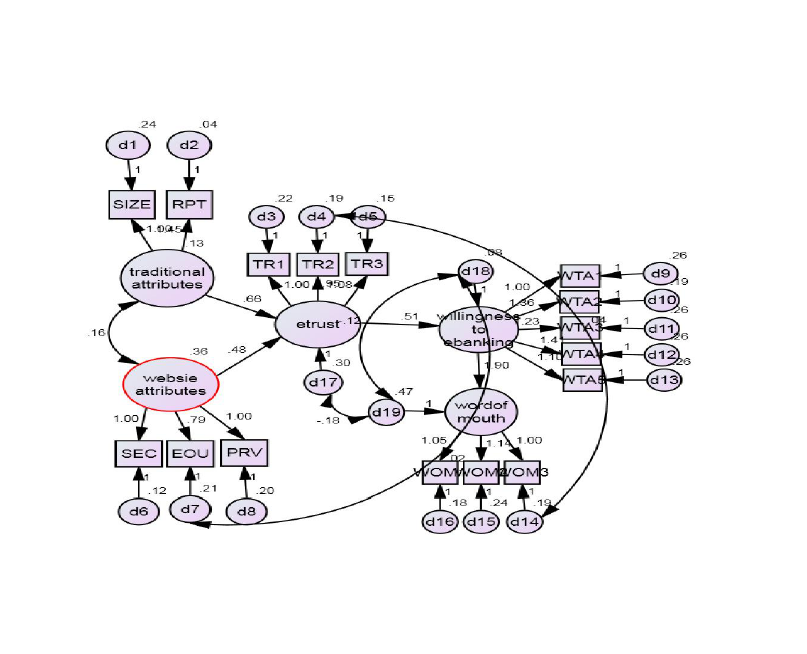
Fig. 2. The summary of structural equation